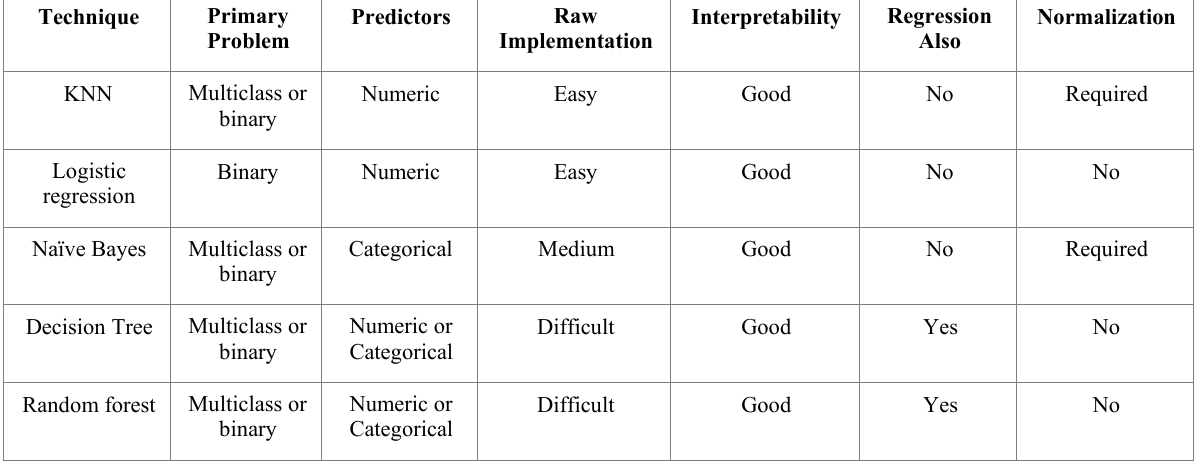
Table 3. Comparisons of Machine Learning Techniques